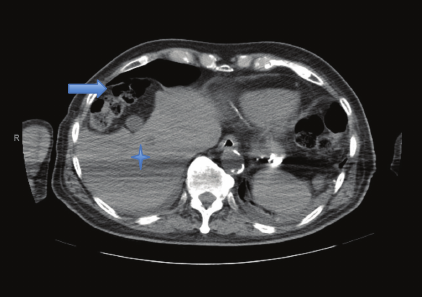
Figure 1: CT of the abdomen (axial section) showing a loop of colon (arrow) between the liver (asterisk) and the right hemidiaphragm.